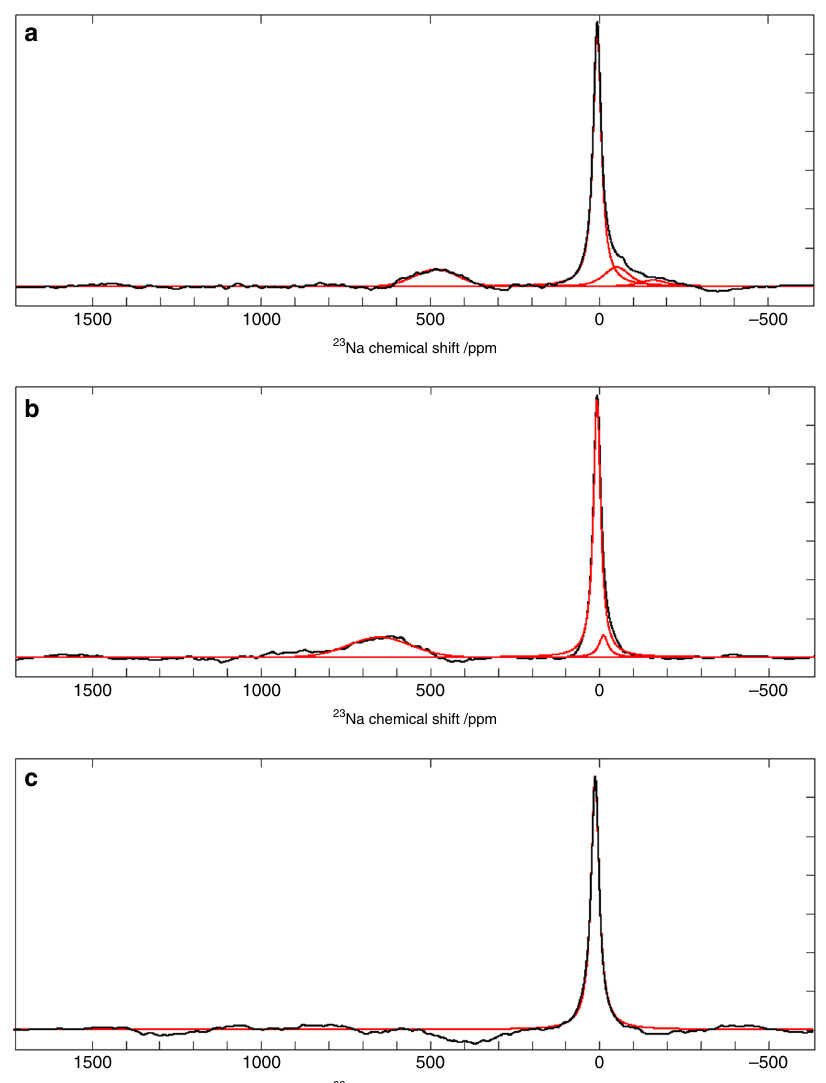
Fig. 7 In situ 23 Na NMR spectra for a NIB full-cell charged to 4.18 V at 86 mA g − 1 . 23 Na NMR spectra immediately after charging ( a ), 4 h after charging ( b ) and after discharging ( c ). Experimental spectra are shown in black and the fi tted peaks are given in red. Deconvolution values for these spectra can be found in Supplementary Table